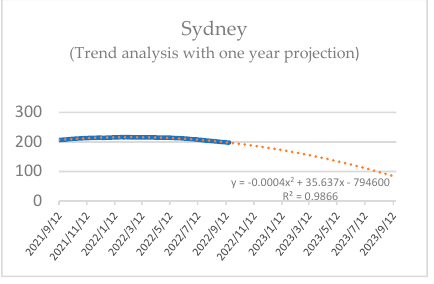
Figure 6. Trend analysis and one year prediction on housing prices for Sydney.